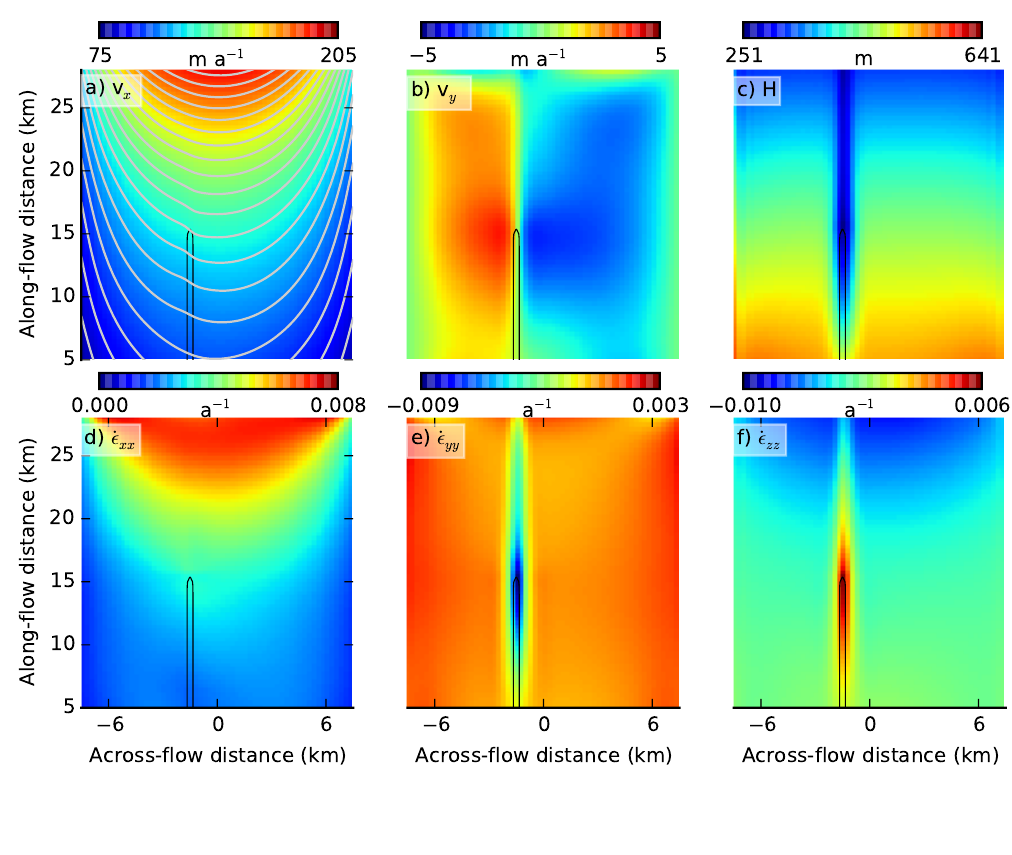
Figure 6. Steady-state results for a laterally constrained ice shelf (MS5, Table 1) showing the horizontal velocities (a, b) , ice thickness (c) , and principal strain rates (d–f) . Gray contours mark surface speed in (a) , black curves in (a) – (f) delineate zones of channelized basal melting. For a cross section see Fig. 7a.